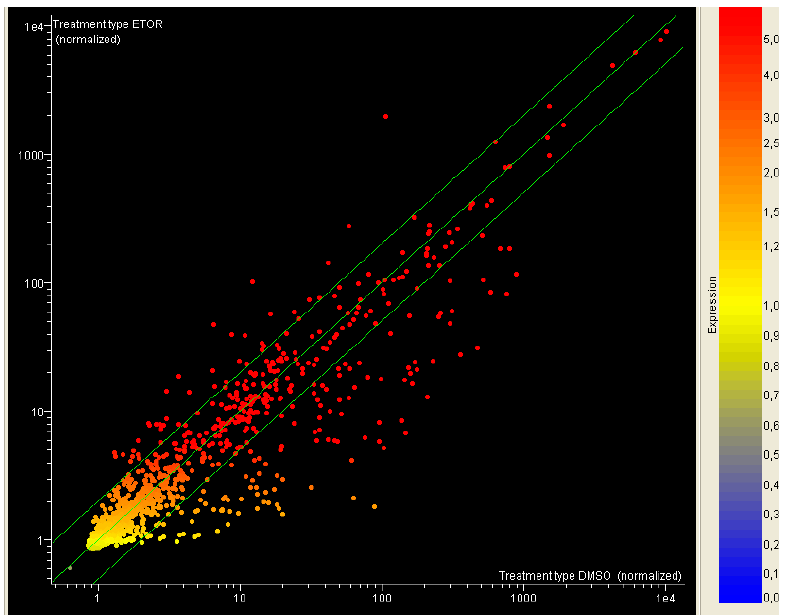
Figure 1. Scatter plot analysis reporting the variation of miRNA expression between HTLA-230 (horizontal axis) and ER-HTLA cells (vertical axis). Each dot represents one miRNA colored according to its level of expression. Green diagonal lines indicate the 1.5-fold variation interval.